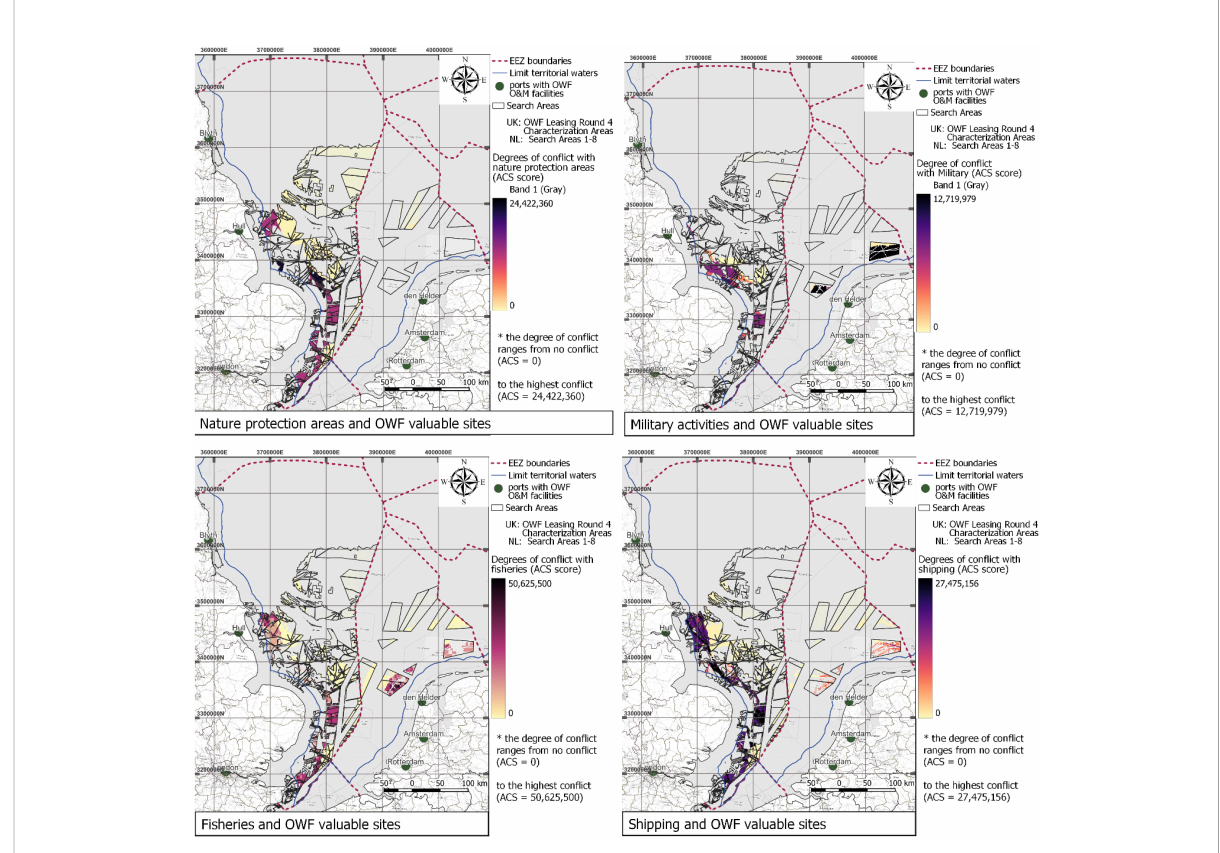
FIGURE 15 Distribution of con fl ict areas within the Search areas for future OWF developments, beyond 2030, by sea